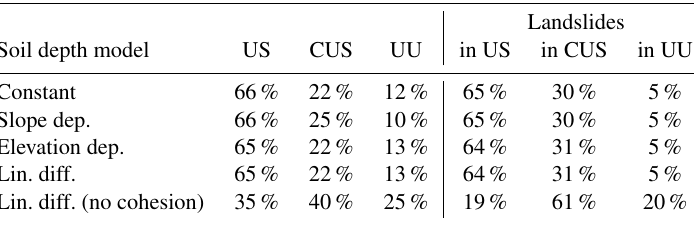
Table 1. Percentage of unconditionally stable (US), conditionally (un)stable (CUS), and unconditionally unstable (UU) cells in Switzerland according to the FoS calculations for each soil depth model and percentage of landslides in each condition from the landslide inventory. For the linear diffusion model, the results are also shown when cohesion is neglected ( c = 0). Landslides